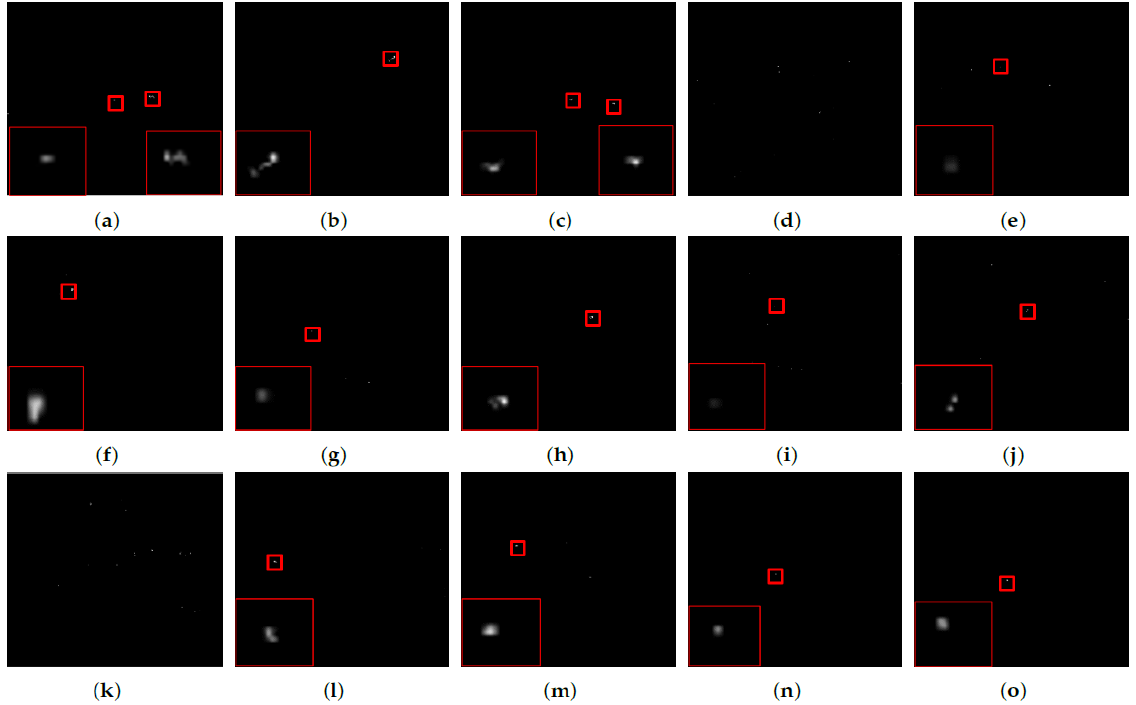
Figure 21. The detection results of the original images’ added noise with mean 0 and variance 0.01. ( a – o ) represent the corresponding scenes in Figure